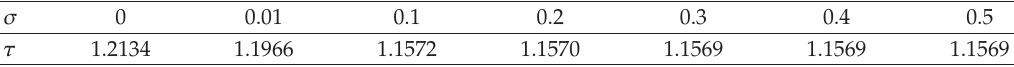
Table 1: d M (cid:8) 0 . 01.